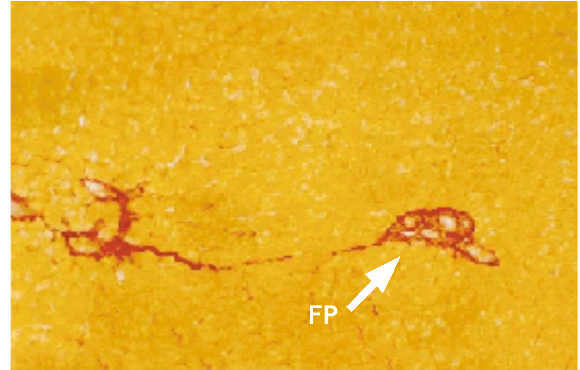
FIGURA 11 - Fotografia apresentando o preparado histológico do grupo 4 (LDB – ligados tratados . com quercetina 14